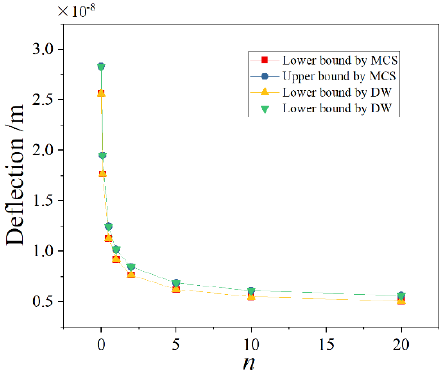
Appl. Sci. 2022 , 12 , 9896 Figure 9. The deflection calculated by DW and MCS with different n . Figure 9. The deflection calculated by DW and MCS with different n .